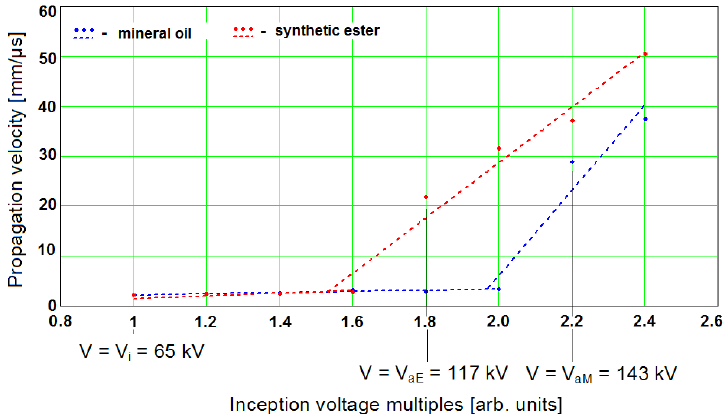
Figure 6. Relationship between the propagation velocity of positive streamers and multiples of inception voltage: d = 20 mm, V i —inception voltage of the streamers, V aE —acceleration voltage of streamers in synthetic ester liquid, V aM —acceleration voltage of streamers in mineral oil, red dots – average propagation velocity of streamers in synthetic ester obtained from experiment, red dotted line – regression line for propagation velocity of streamers in synthetic ester, blue dots – average propagation velocity of streamers in mineral oil obtained from experiment, blue dotted line – regression line for propagation velocity of streamers in mineral oil [61].